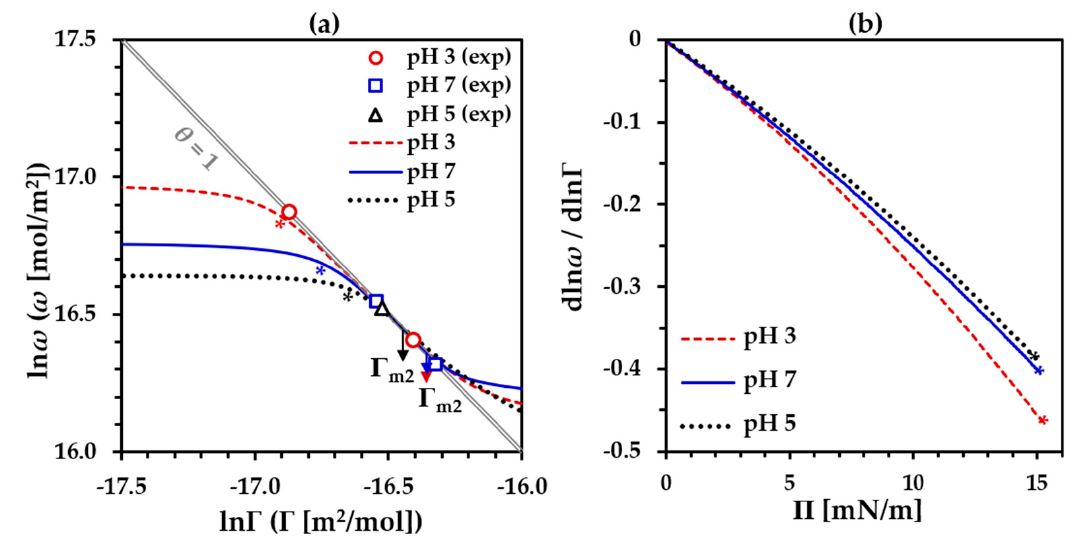
Figure 4. BLG adsorption layers at the water/air interface at different bulk pH. ( a ) ln ω (ln Γ ) dependencies; (symbols) experimental data [24], (lines) computations via Equations (1)–(10); asterisks indicate the critical points at coordinates ( ω *, Γ *), arrows indicate Γ m2 , the double-line diagonal corresponds to θ = ω Γ = 1, i.e., full saturation of the primary monolayer. ( b ) Distribution of the derivative dln ω /dln Γ over surface pressure; asterisks indicate Π *.